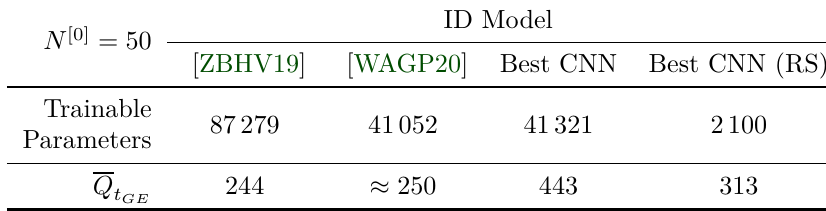
Table 8: Comparison of the top generated CNNs for the ASCAD N [0] = 50 ID model experiments with the current